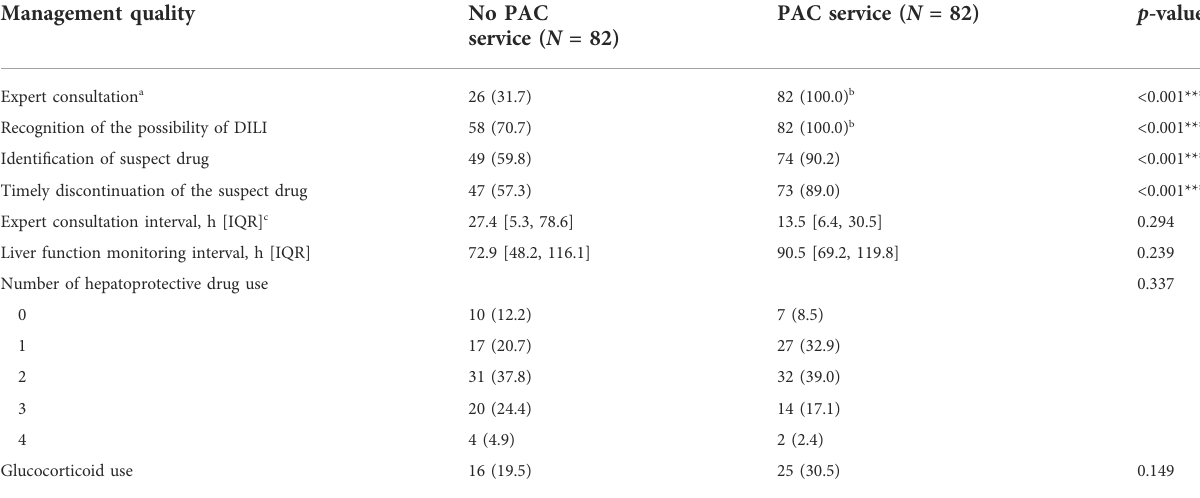
TABLE 5 Quality of medical care in the propensity score-matched cohort of drug-induced liver injury patients. Management